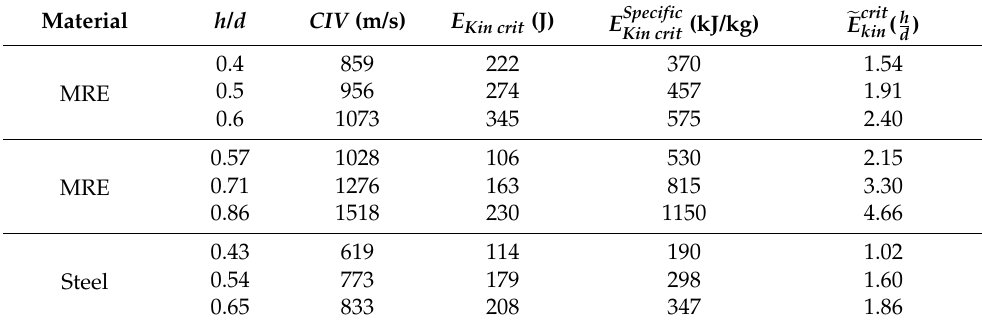
evaluated from shots listed in Table 3. kin